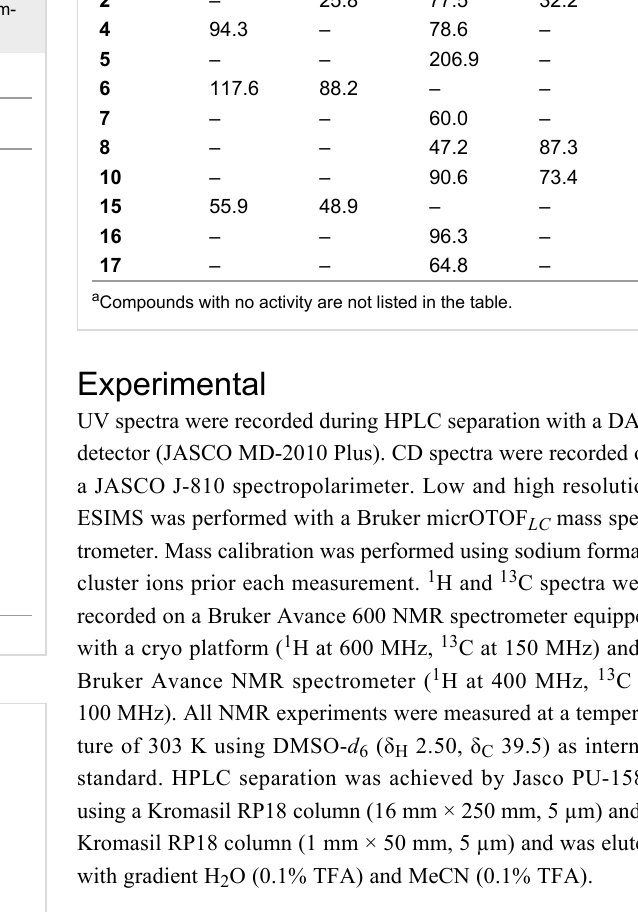
The new compounds 14-debromo-11-deoxyfistularin-3 ( 1 ) and aplysinin A ( 2 ) were tested for their antimicrobial activity against different Gram-positive and Gram-negative bacteria,